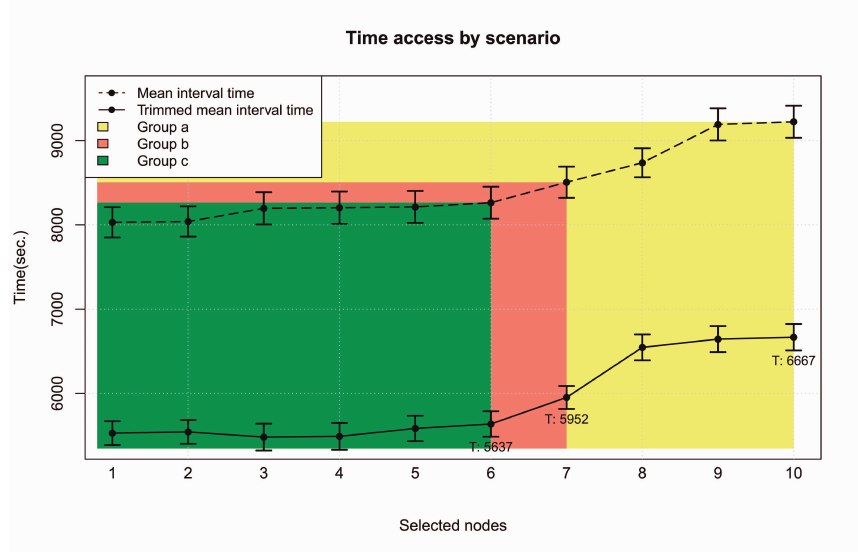
Figure 6. Mean access time (arithmetic and trimmed means) for each new PEC and scenario. Main effects, selected nodes factor (mean and 95% confidence interval). Means with different letters (rectangles) are significantly different (lincon multiple comparisons, p < 0.05).